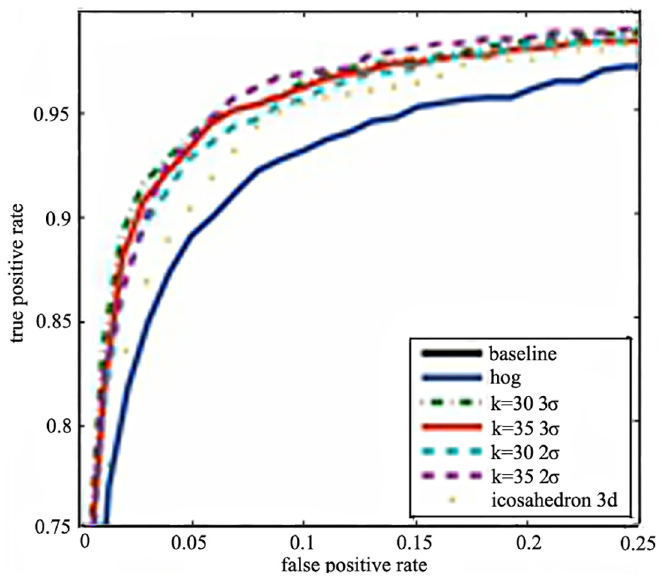
Fig 3. The performance of 3D normals projected by polyhedron and random matrix.